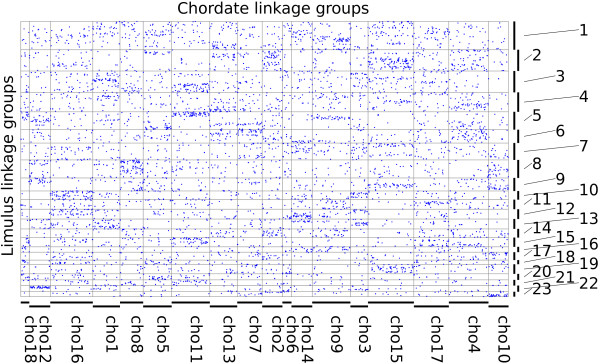
Limulus-Human macro-synteny dot plot. Blue points indicate the position of human genes in reconstructed ancestral chordate ALGs (vertical displacement) and their candidate orthologs in the 30 L. polyphemus linkage groups (horizontal displacement).